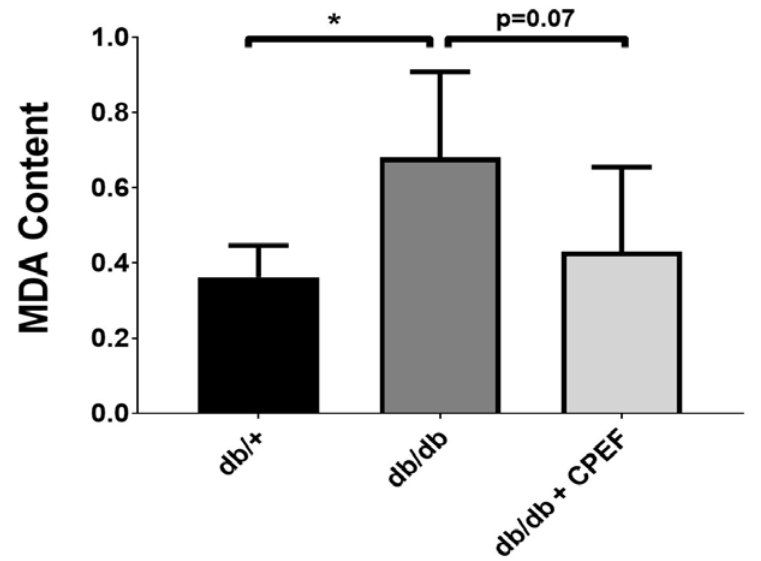
Figure 4. The effect of CPEF treatment on lipid peroxidation in the liver of db/db mice. Mice were treated with the vehicle control or CPEF (351.5 mg/kg) daily for 28 days. Lipid peroxidation was assessed by quantifying the malondialdehyde (MDA) content using TBARS assay in the liver homogenates and normalised to protein content ( µ mol/mg protein). Data are represented as the mean ± SD ( n = 6–8). Statistical significance between the groups is denoted as * p < 0.05 compared to the db/db control group.